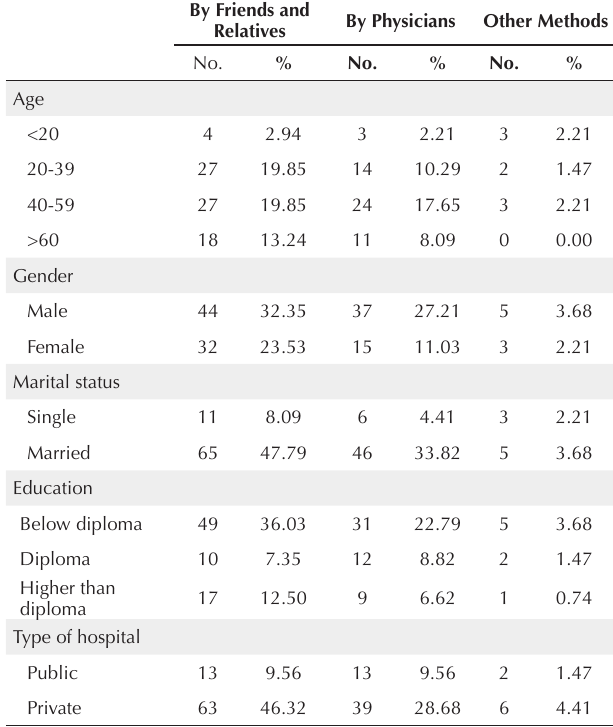
Table 2. The Impact of Demographic Variables on Choice of